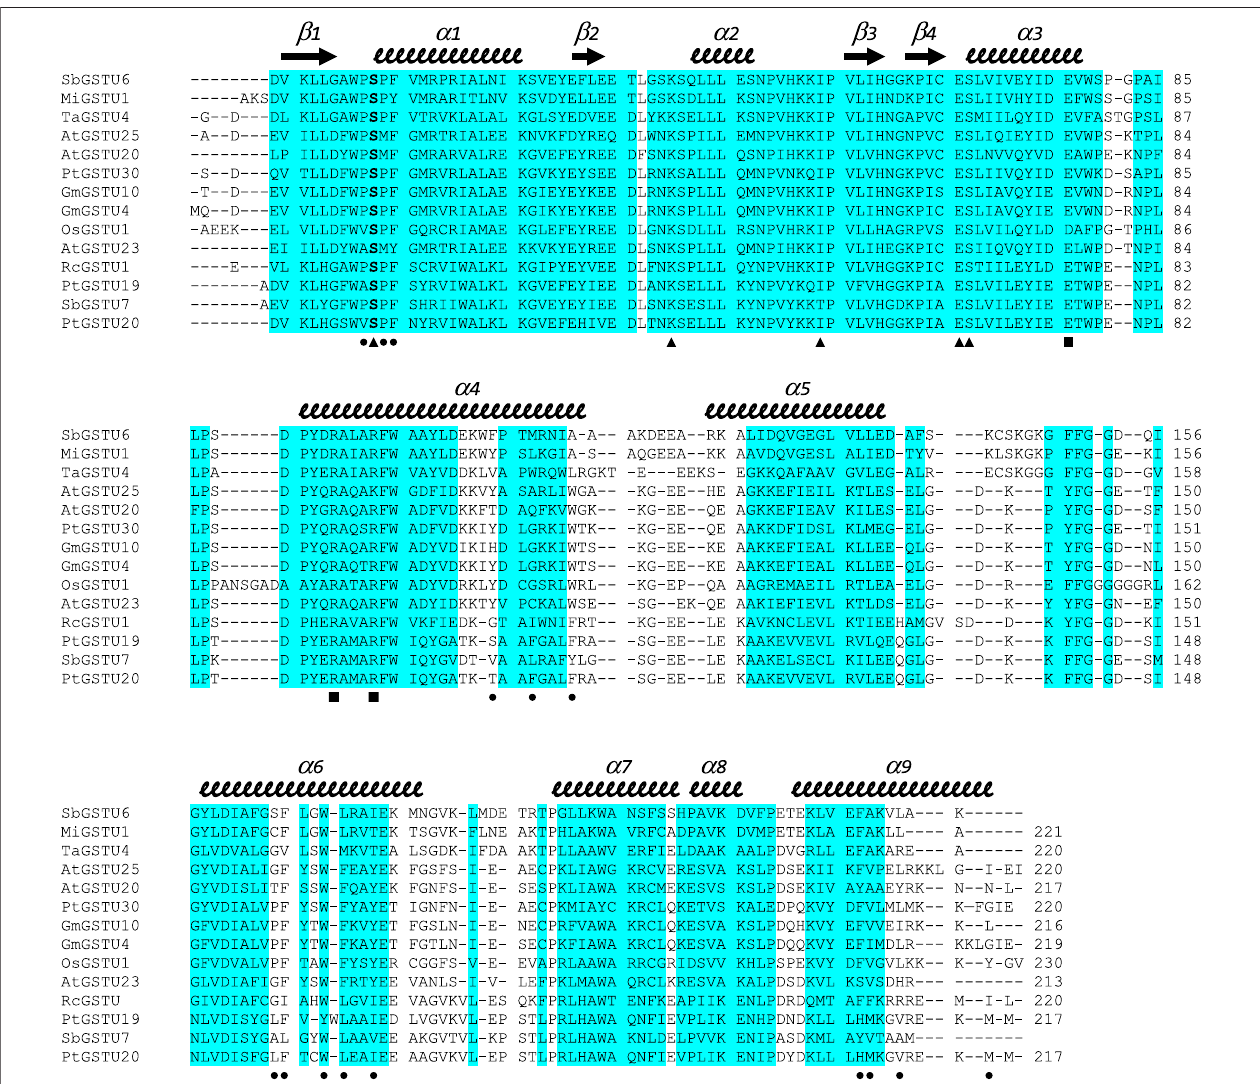
FIGURE 2 | Structure-based sequence alignment of GSTUs highlighting common regions. The sequence alignment was generated with mTM-align. Sequences wereretrievedfromtheRCSBPDB:SbGSTU6(GSTU6from Salixbabylonica ,PDBID7DW2),MiGSTU1(GSTU1from Mangiferaindica ,5G5E),TaGSTU4(GSTU4from Aegilops tauschii , 1GWC), AtGSTU25 (GSTU25 from Arabidopsis thaliana , 5G5A), AtGSTU20 (GSTU20 from A. thaliana , 5ECS), PtGSTU30 (GSTU30 from P. trichocarpa , 5J4U), GmGSTU10 (GSTU10 from Glycine max , 4CHS), GmGSTU4 (GSTU4 from G. max , 2VO4), OsGSTU1 (GSTU1 from Oryza sativa , 1OYJ), AtGSTU23(GSTU23 from A. thaliana , 6EP7), RcGSTU1(GSTU1 from Ricinuscommunis , 4J2F), PtGSTU19 (thisstudy), SbGSTU7 (GSTU7 from S.babylonica , PDB ID 7DWD),andPtGSTU20(thisstudy).Secondarystructuresarelabeledandshownusingarrows( β -strands)andsquiggles(helices).Commonregions, i.e. ,regionswithno gap and with pairwise residue distances less than 4Å are highlighted in blue. Residues participating in dimer stabilization via polar interactions are marked with ■ . Residues involved in glutathione binding (G-site) are marked with ▲ . Residues involved in the putative H-site of PtGSTU20 are marked with C .